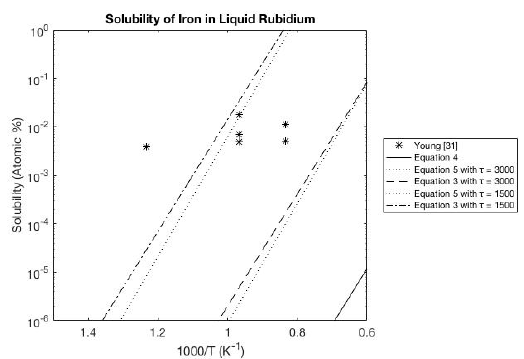
Figure 10. Solubility of iron in liquid rubidium.